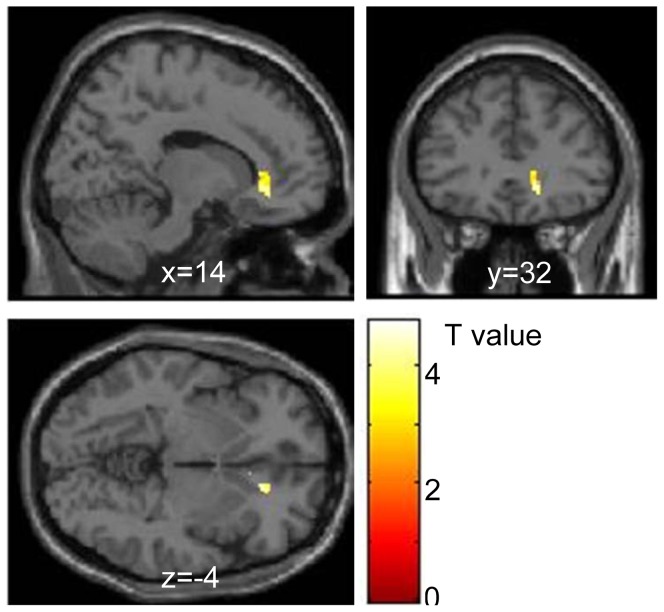
Difference in functional connectivity between sleep control (SC) and sleep debt (SD) sessions.The map shows greater functional connectivity between the left amygdala and other voxels in the brain in SC than SD session. Significant differences were found in the vACC, peak MNI coordinate (x, y, z) = (14, 32, −4) mm, T(13) = 4.77, p = .0001, k = 9 contiguous voxels. The significant cluster with a stronger connection with the left amygdala is rendered on a T1 anatomical referential image displayed in neurological convention, with the left side corresponding to the left hemisphere. The clusters shown are thresholded with a lenient alpha level (p<0.01, k>5) for visualization purposes. MNI, Montreal Neurological Institute template; vACC, ventral anterior cingulate cortex.